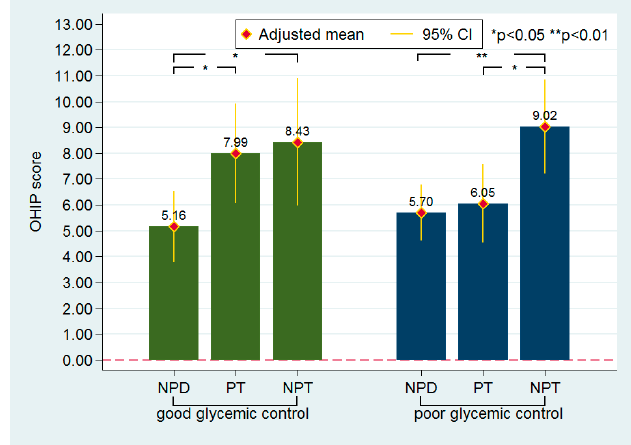
Figure 1. The levels of oral health ‐ related quality of life (OHQoL) in different periodontal treatment experience groups stratified by glycemic control status. NPD: non-periodontal disease; NPT: non-periodontal treatment; PT: periodontal treatment. Adjusted means indicate the estimated values adjusted for the age, gender, type 2 diabetes mellitus duration, education level, and routine dental